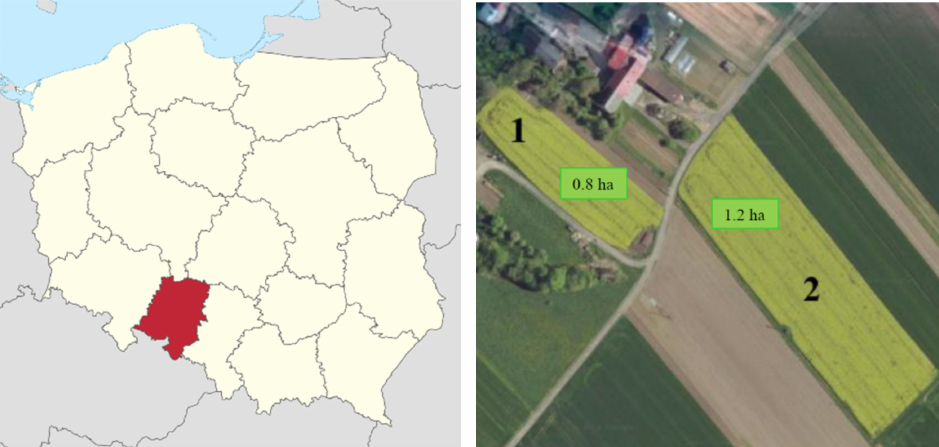
Figure 1. Location and aerial view of experiment fields (Prudnik 50 ◦ 19 (cid:48) 11 (cid:48)(cid:48) N 17 ◦ 34 (cid:48) 45 (cid:48)(cid:48) E, Poland). 1. View on the field experiment in 2018; 2. View on the field experiment in